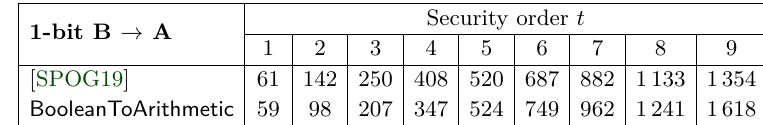
Table 12: Number of cycles to perform a 1-bit Boolean to arithmetic modulo q conversion for q =